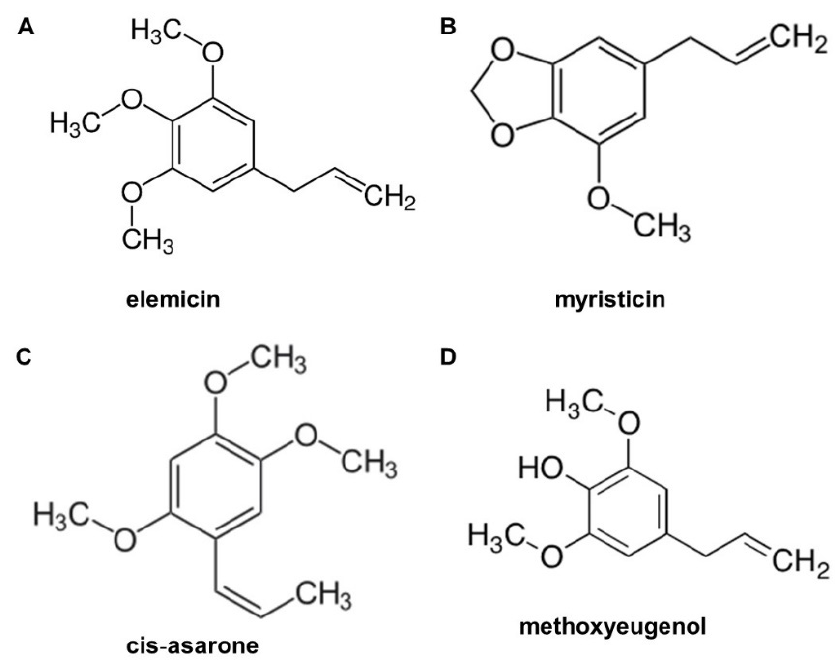
Figure 5. Molecular structure of active compounds found in nutmeg extractions. ( A ) elemicin, ( B ) myristicin, ( C ) cis-asarone, and ( D ) methoxyeugenol. Several families of proteins capable of multiple drug extrusion have been